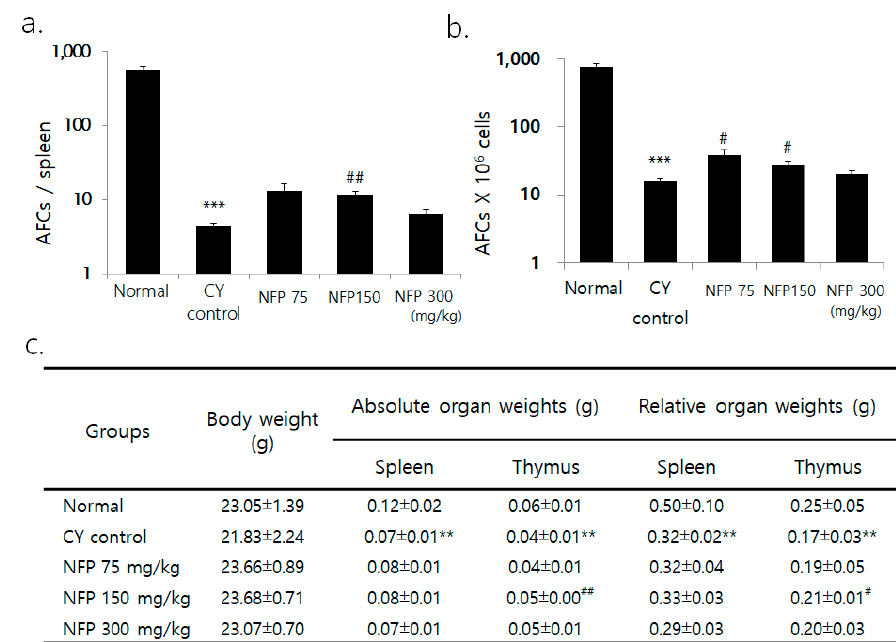
Figure 3. Effects of NFP on antibody-forming cells (AFCs) and splenic subpopulation in Bagg Albino (BALB / c) mice treated with cyclophosphamide (CY). ( a ) Decrease in AFCs / spleen from the normal group at *** p < 0.001, increase in AFCs / spleen in the NFP 150 mg / kg groups compared with the CY control at ## p < 0.01. ( b ) Decrease in AFCs ( × 10 6 ) cells from the normal group at *** p < 0.001, increase in AFCs ( × 10 6 ) / spleen in the NFP 75, 150 mg / kg-treated groups compared with the CY control at # p < 0.05. ( c ) Comparing the normal group and the CY control group shows a decrease of ** p < 0.01. However, in the NFP group administered with 150 mg / kg, the absolute organ weight ( ## p < 0.01) and relative organ weight ( # p < 0.05) of the thymus increased. The data represent means ± standard error of the mean (SEM) ( n = 8).